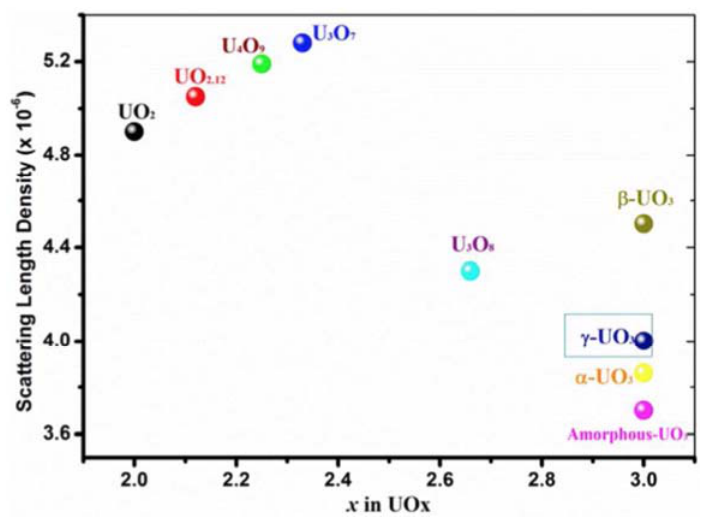
Figure 6. The calculated values of the nuclear scattering length density (SLD) for some common phases in uranium ‐ oxide system. The calculations are based on specific densities published in literature [73,74].